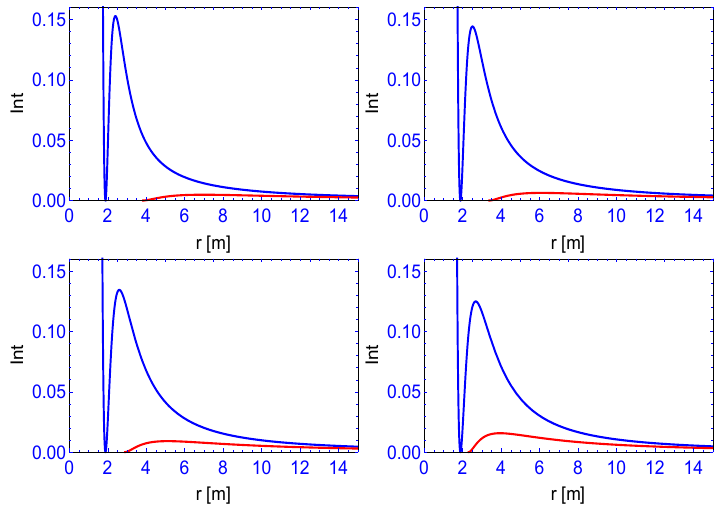
Figure 7. The intensity distribution for pc-GR (upper) curve and GR (lower curve). The rotational parameter a is changed from 0.6 m 0 to 0.9 m 0 ( m = m 0 ) starting on the left in the upper row and ending to the right in the lower row, in steps of 0.1 m 0 . The intensity in pc-GR is always larger. The peak shifts to the left (lower distances) as a increases. For a = 0.9 m 0 , the peak is around r = 0.4 m 0 , while the peak of the pc-GR curve is always at lower r . The intensities are obtained using (23). The relation between L z and E can be retrieved from